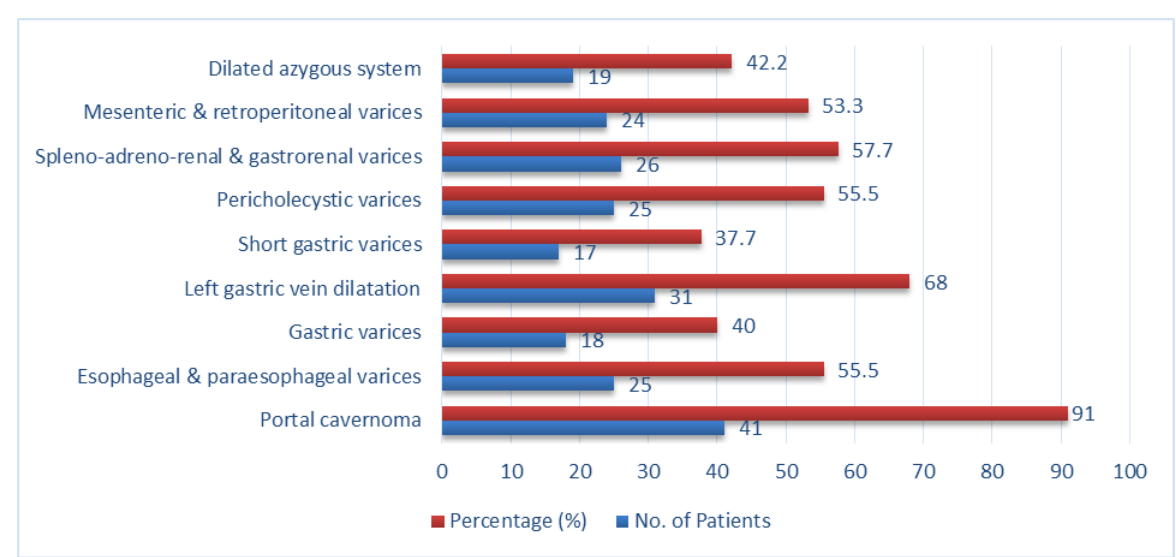
Fig. 9. The collateral distribution on